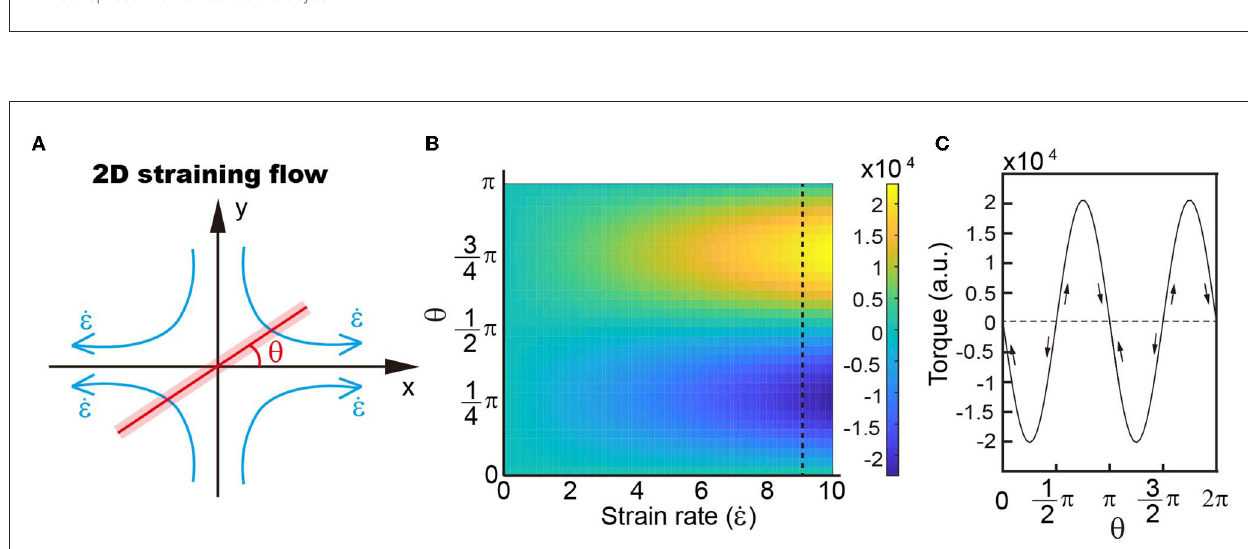
FIGURE3 (A) Schematic showing the simplified model of four recirculating flow patterns. (B) Distribution of torques with different strain rates and object angles with respect to the outwards flow shown in a. Our results demonstrate that the torque distribution depends on the angle rather than the strain rate. (C) Variations in torque when the object rotates within the velocity